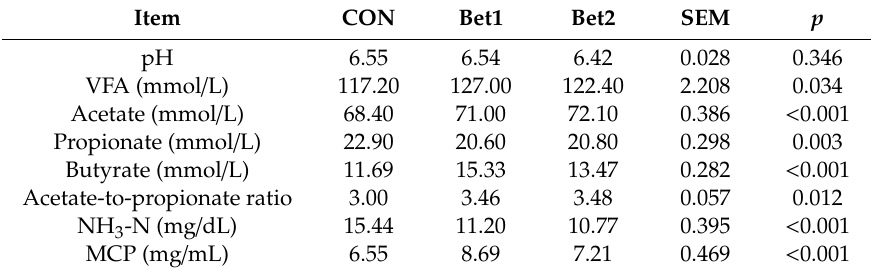
Table 3. E ff ect of betaine on rumen fermentation of dairy cows. Item